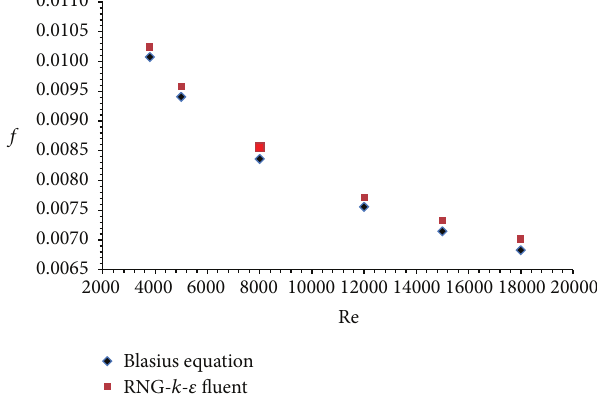
Figure 5: Validation of Blasius empirical correlation with RNG- 𝑘 - 𝜀 FLUENT model.